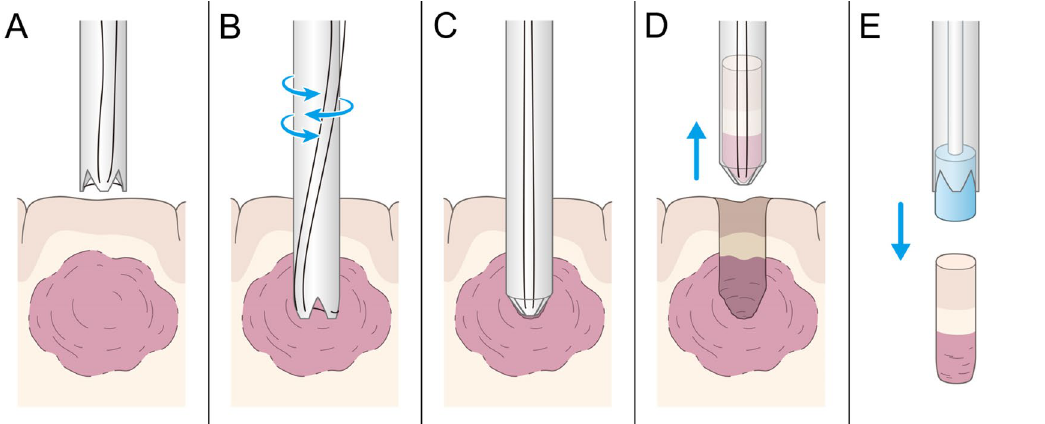
Figure 1. Scheme of boring biopsy method for intraparenchymal lesion, including tool insertion ( A , B ), specimen isolation and transection with a closing tip tool ( C ), cylindrical tissue sampling ( D ), and specimen removal ( E ). This method facilitates obtaining a vertically long column of the specimen, ranging from the normal cortex to the core of the